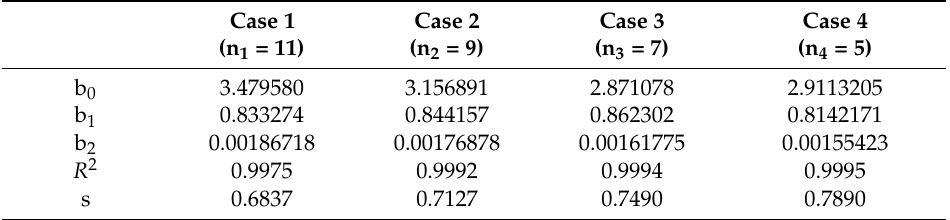
Table 9. Estimated parameters and evaluation criteria for the 2nd order polynomial equations for HMP 140A capacitive sensors using four different calibration